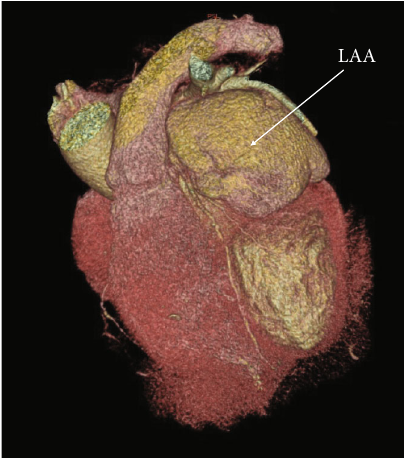
Figure 2: Cardiac CT depicting the LAA. Angiographic “ shadow ” of the